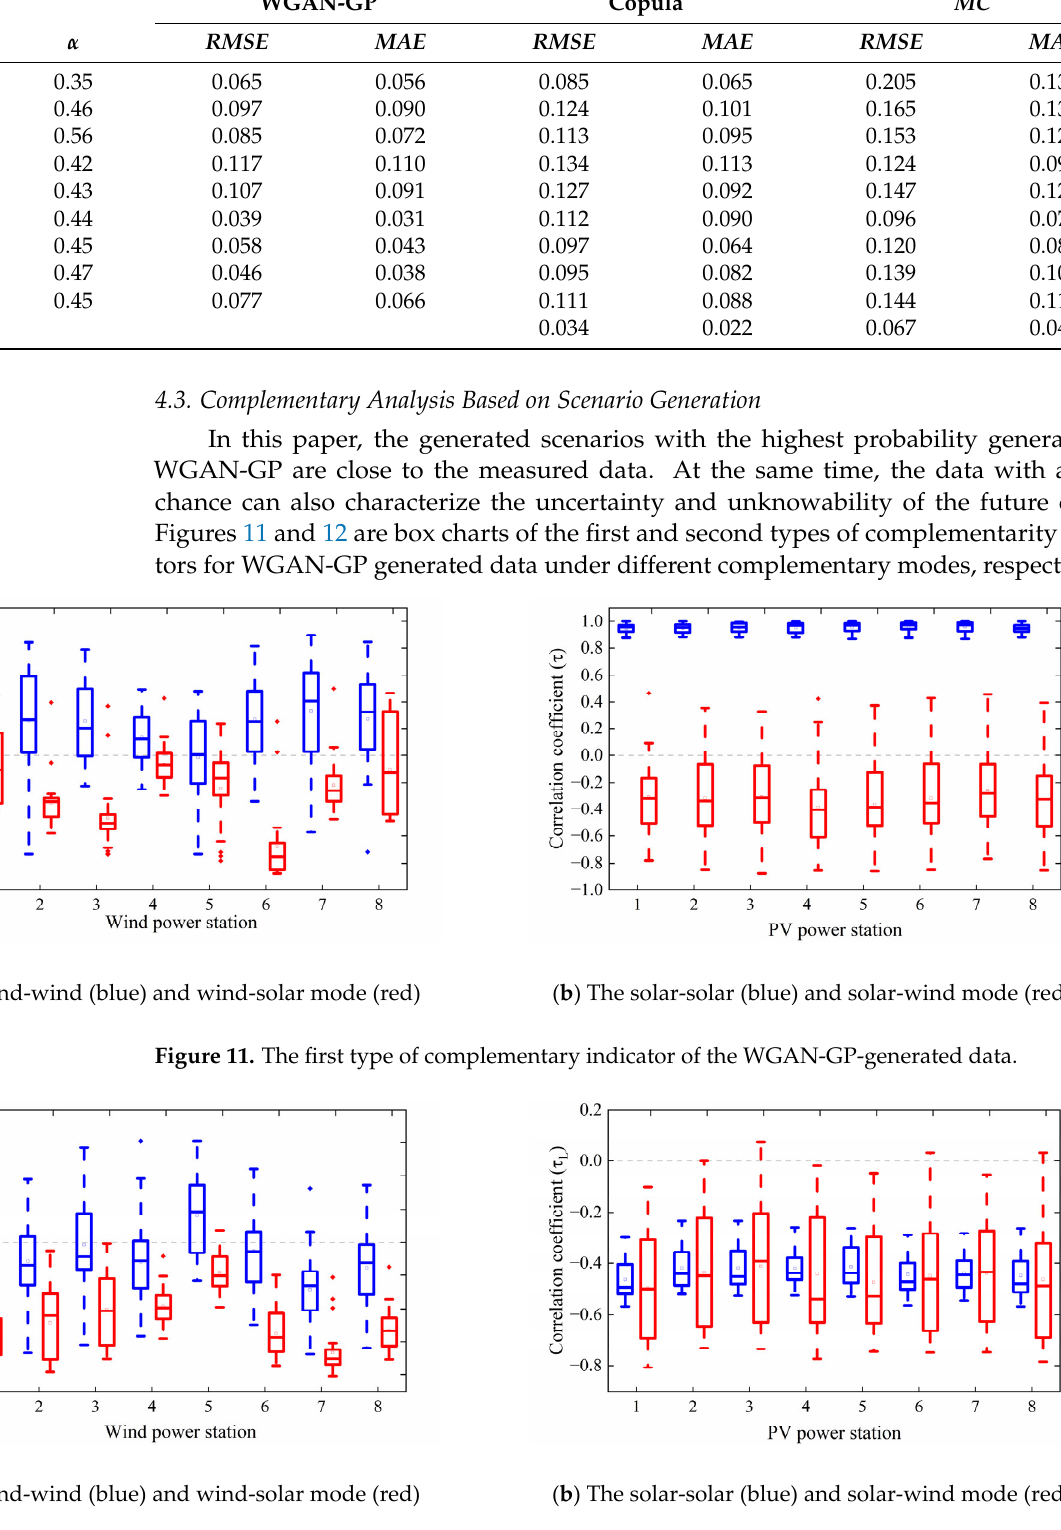
Figure 12. The second type of complementary indicator of the WGAN-GP-generated data.